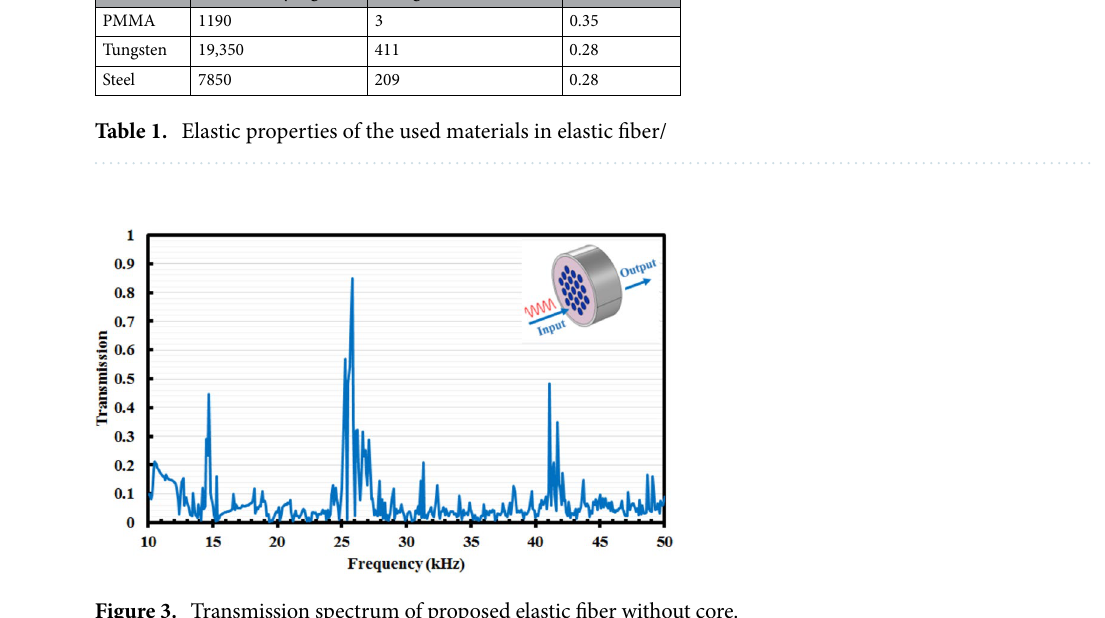
Figure 2. ( a ) Total schematics of the proposed phononic crystal fiber, and ( b ) piezoelectric location at the end of fiber core. Material